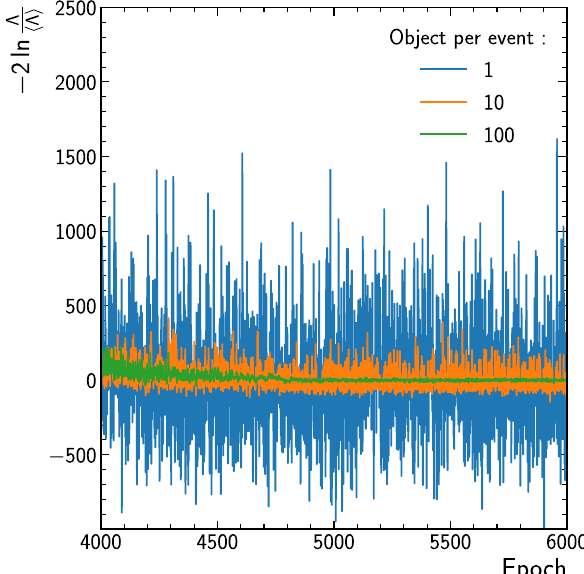
Fig. 2 Comparison of the − 2ln (cid:5) metric evolution during training for different numbers of objects generated per event using different random latentspaces.Eachmetricisshiftedbyitsaverageoverthelastthousand (cid:3) 6000 (cid:5) i0 . 001 , where i refers to the epoch number) to epochs ( (cid:7) (cid:5) (cid:8) = i = 5000 better illustrate the